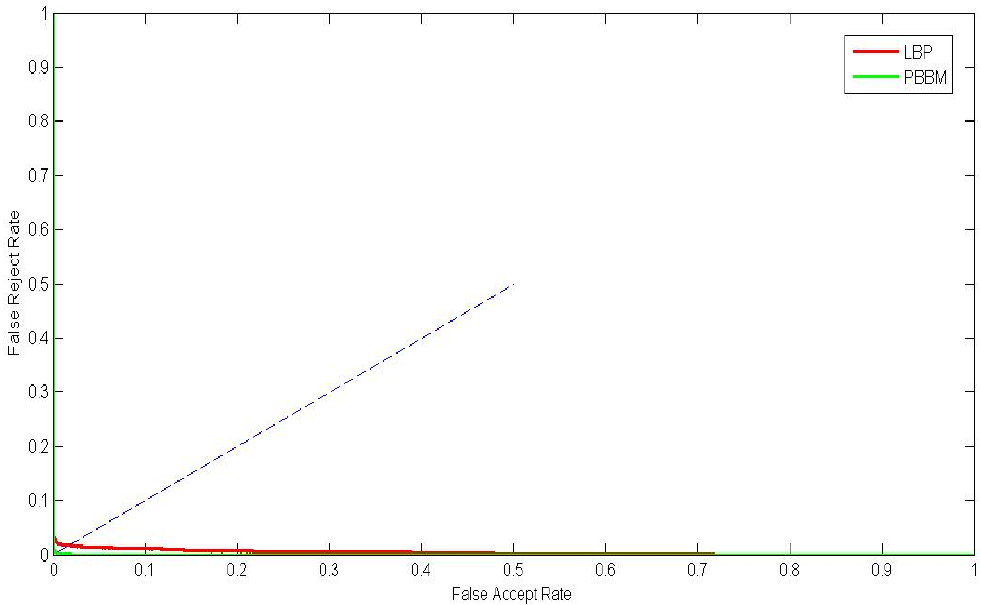
Figure 9. ROC curves by different method.